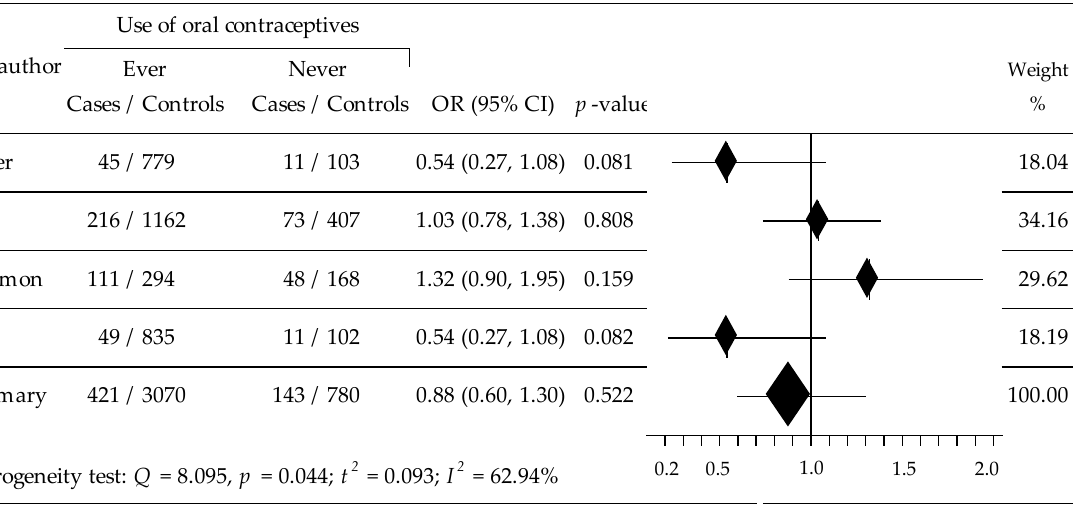
Figure 4. Forest plot for the relationship between OC taking and HER2+BC risk.